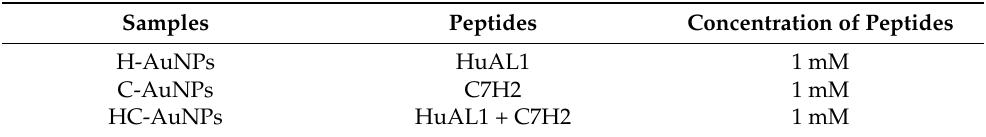
Table 1. Final concentration of peptides in the conjugated AuNPs